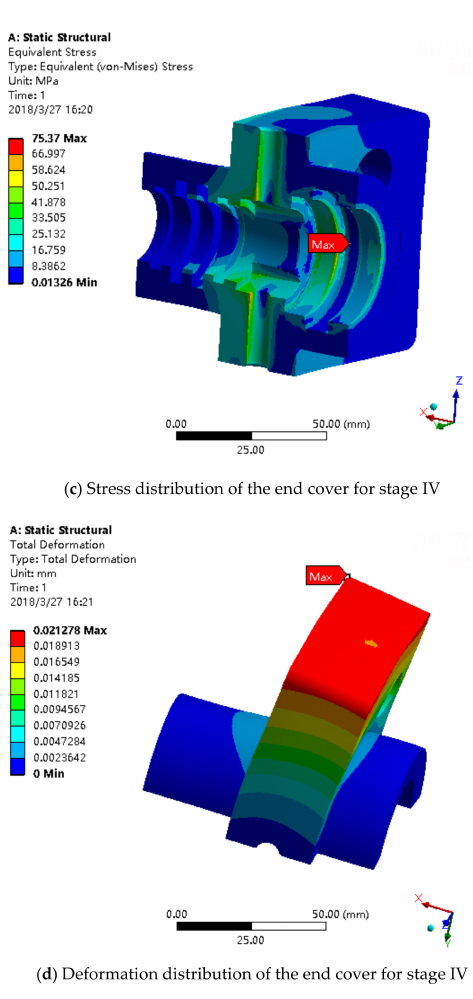
Figure 11. Stress and deformation distributions of the end covers for stages II and IV.